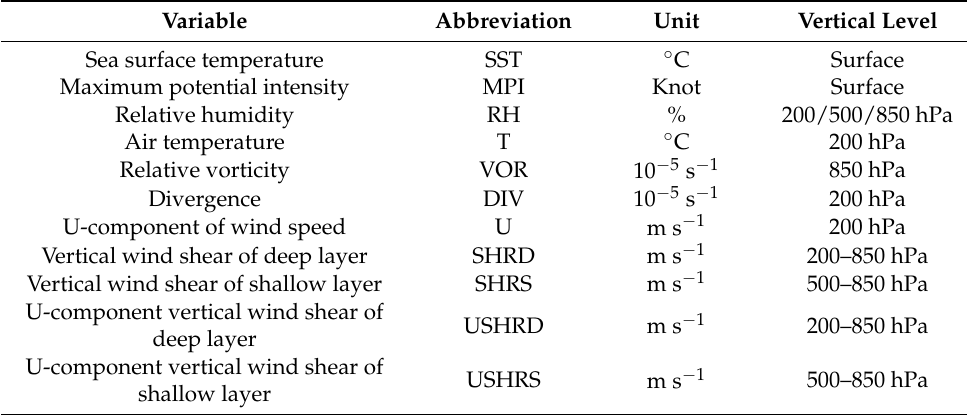
Table 4. Variables used as environmental features in the